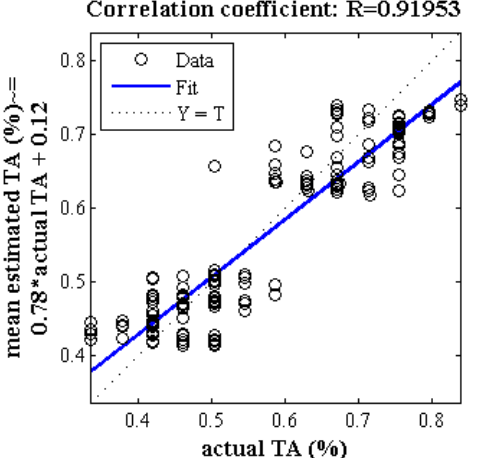
Figure 2. Correlation analysis of a scatter plot between the mean estimated and measured chemical properties of TA of Gala cultivar (test set) by ANN-PSO algorithm based on spectral data related to key wavelengths in 300 replications.